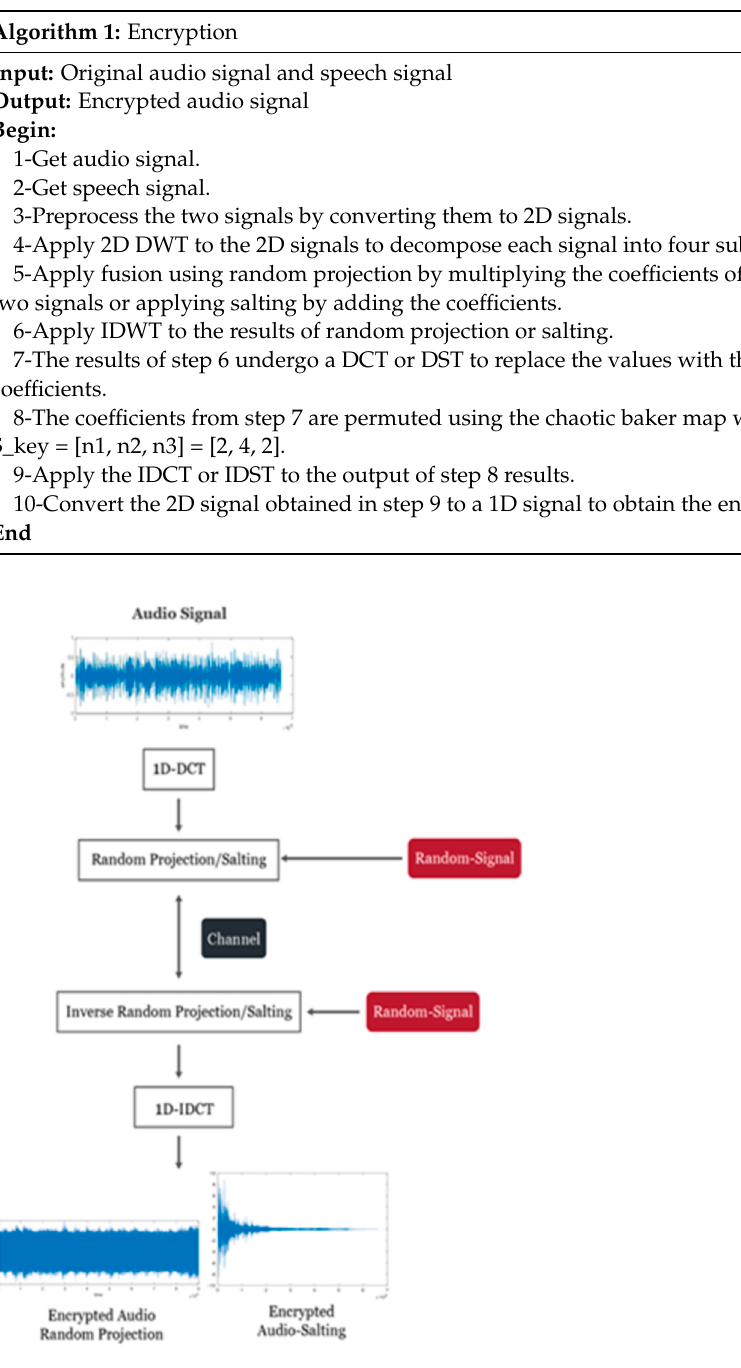
Figure 3. Diagram of the proposed 1D-DCT encryption of audio signals.